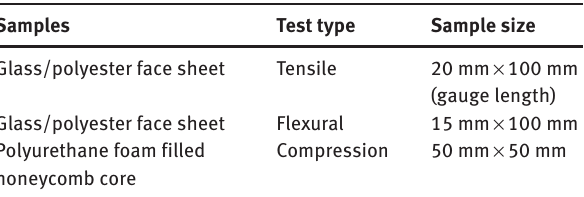
Table 1: Details of samples and tests to determine the mechanical properties of face sheet and foam filled honeycomb core.